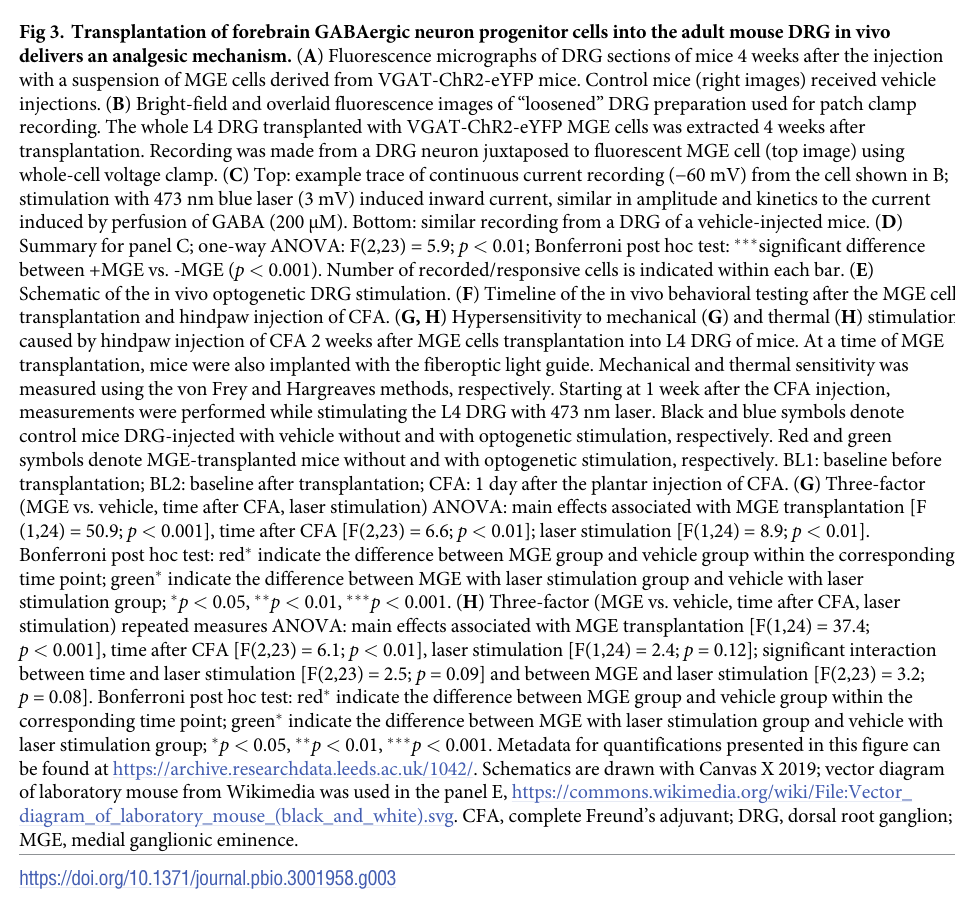
Fig 3. Transplantation of forebrain GABAergic neuron progenitor cells into the adult mouse DRG in vivo delivers an analgesic mechanism. ( A ) Fluorescence micrographs of DRG sections of mice 4 weeks after the injection with a suspension of MGE cells derived from VGAT-ChR2-eYFP mice. Control mice (right images) received vehicle injections. ( B ) Bright-field and overlaid fluorescence images of “loosened” DRG preparation used for patch clamp recording. The whole L4 DRG transplanted with VGAT-ChR2-eYFP MGE cells was extracted 4 weeks after transplantation. Recording was made from a DRG neuron juxtaposed to fluorescent MGE cell (top image)